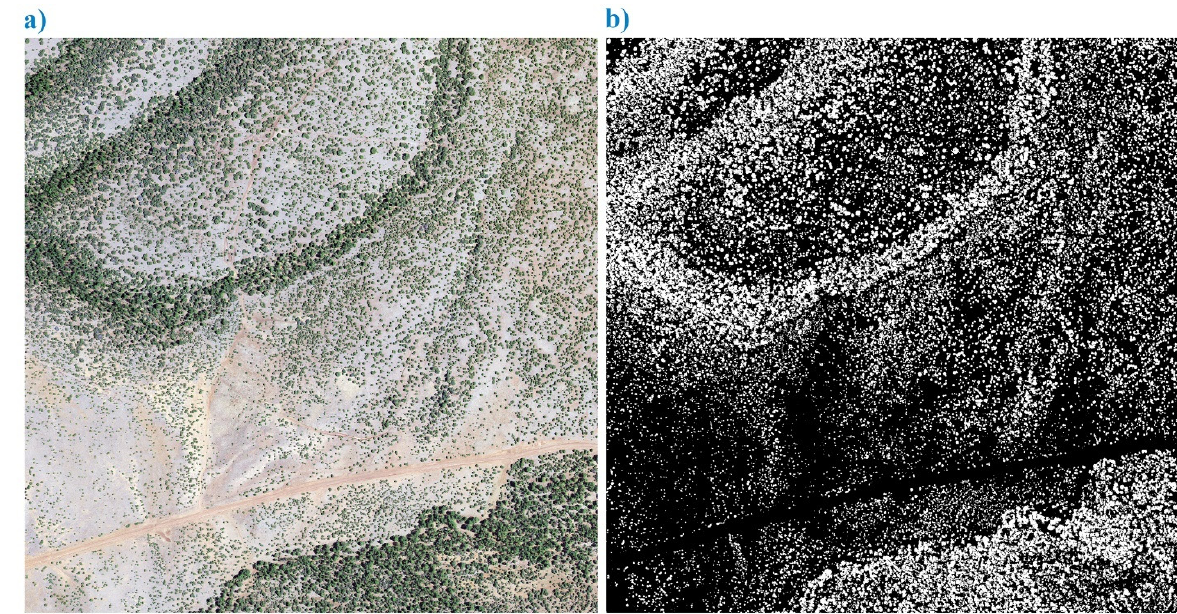
Figure 5. Example of aerial imagery and resultant canopy map. ( a ) Close up of 2017 NAIP aerial imagery (displayed as true color) showing woodland and forest trees; ( b ) close up of derived 2017 tree/large shrub canopy map (same area).